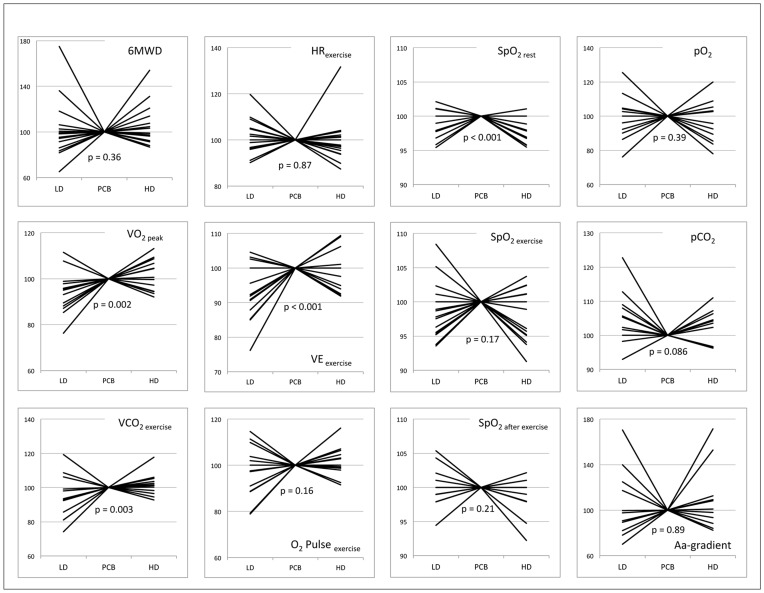
Improvement/worsening (in %) of outcome parameters in individual subjects after low dose iloprost inhalation (LD), high dose iloprost inhalation (HD) and placebo (PCB).Parameters after placebo inhalation were considered 100%. Aa-gradient denotes alveolar-arterial oxygen gradient, HR heart rate, pCO2 partial pressure of carbon dioxide after exercise, pO2 partial pressure of oxygen, SpO2 oxygen saturation, VCO2 carbon dioxide production, VE minute ventilation, VO2 oxygen consumption, 6MWD six-minute walking distance.